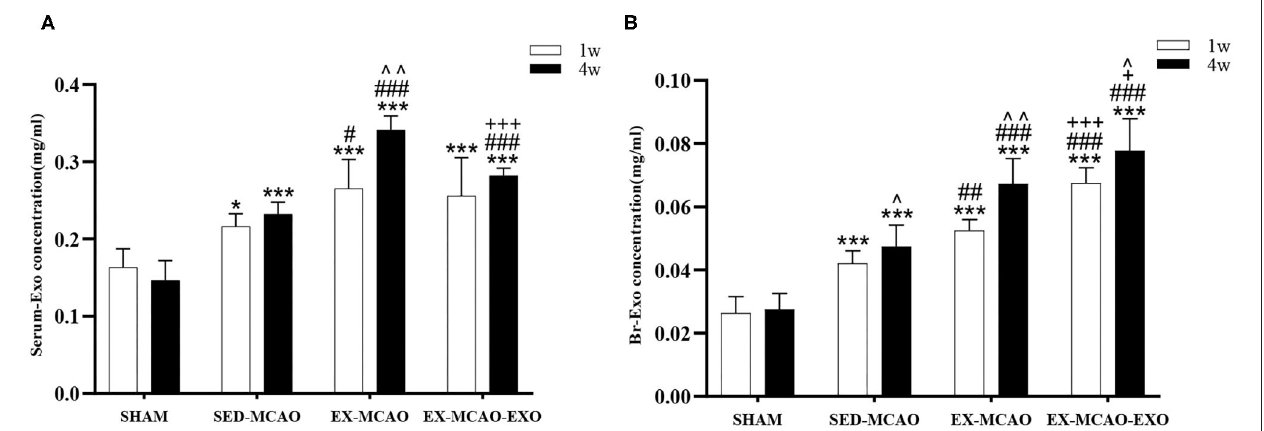
FIGURE 3 | Concentrations of exosomes in the serum and brain of MCAO rats after 1 and 4 weeks of intervention. (A) Serum exosome concentrations. (B) Brain exosome concentrations. Serum-Exo concentration: serum exosome concentration, Br-Exo concentration: brain exosome concentration. ∧ p < 0.05 and ∧∧ p < 0.05 compared with the corresponding levels at 1 week within groups. * p < 0.05 and *** p < 0.001 compared with the corresponding SHAM group. # p < 0.05, ## p < 0.01, and ### p < 0.001 compared with the corresponding SED-MCAO group. + p < 0.05 and +++ p < 0.001 compared with the corresponding EX-MCAO group. Means ± standard deviations, n =